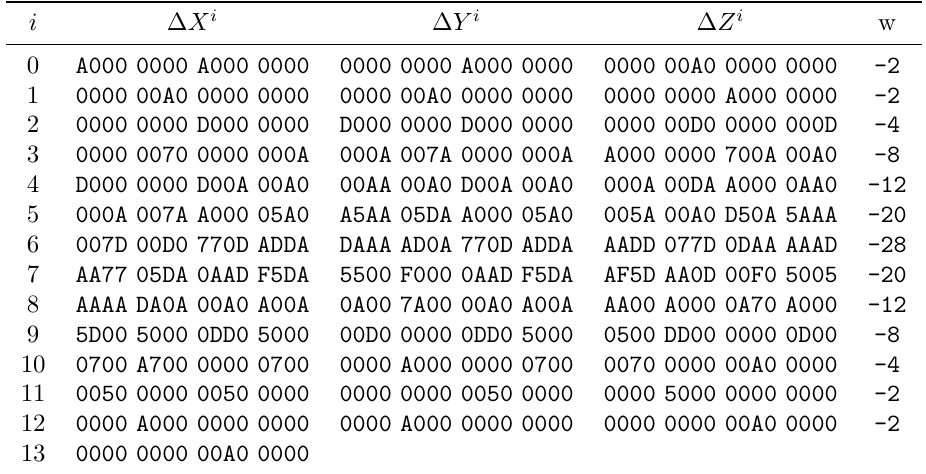
Table 13: A possible differential trail with weight 124, corresponding to the